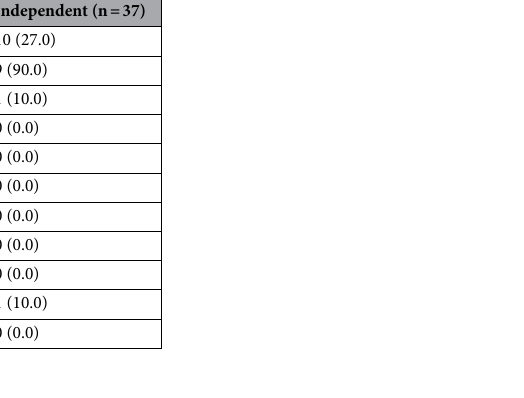
Table 7. Major causes of patient